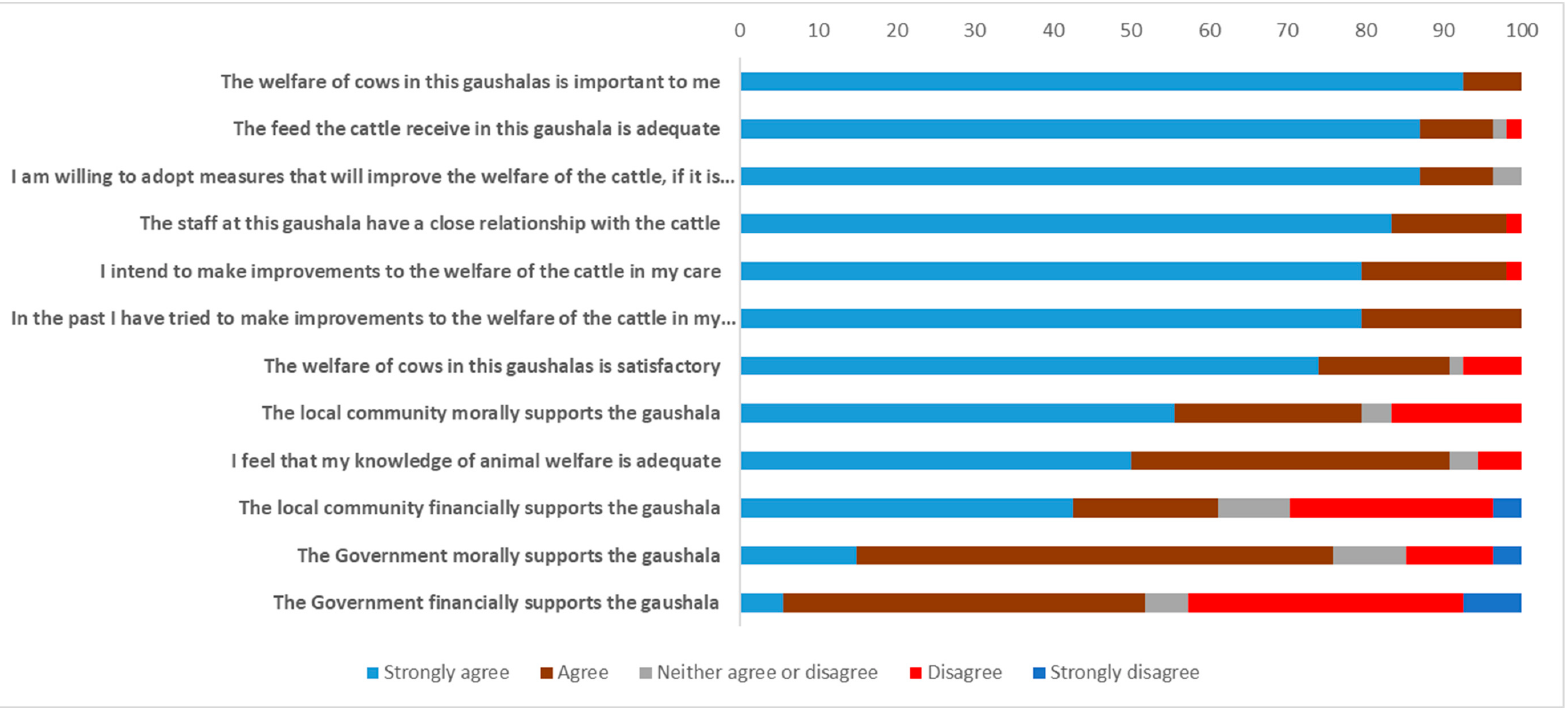
Figure 2. Perceived beliefs and attitudes expressed by 54 gaushala managers.